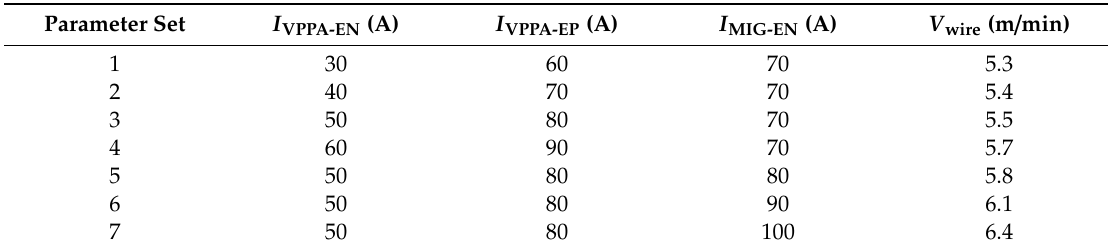
Table 3. Experimental